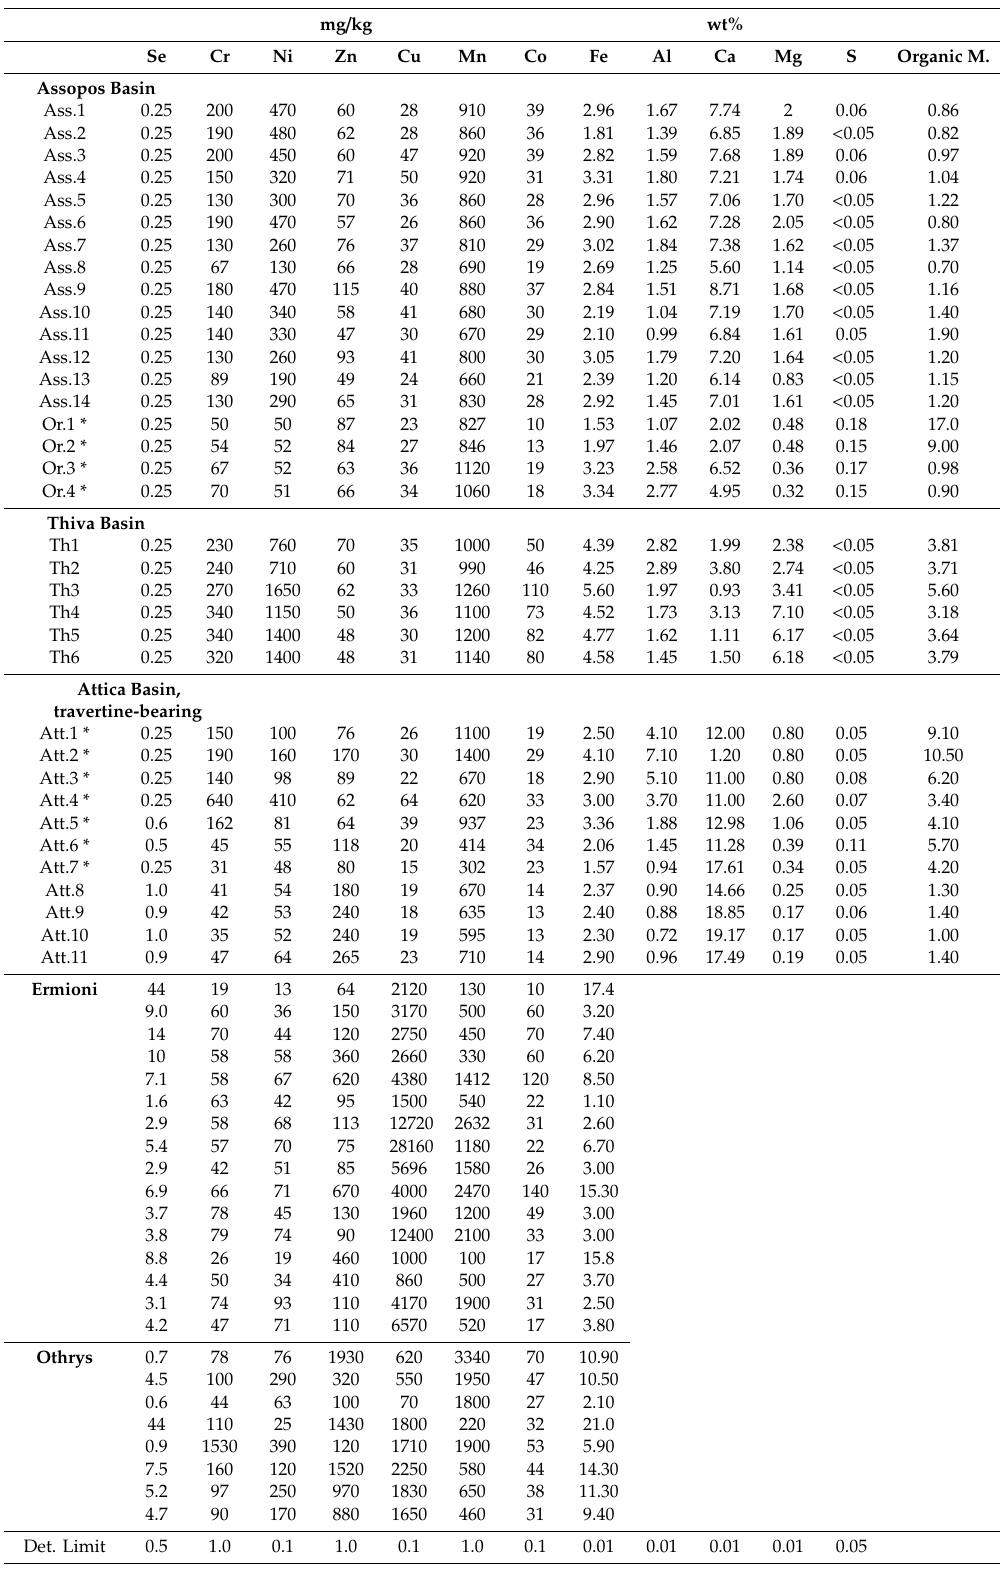
Table 1. Trace element content in soils from Neogene Basins of Greece, in comparison to Ermioni and Othrys soil a ff ected by sulphide mineralization.(Present study *, [15,21–23,31–33]). mg /